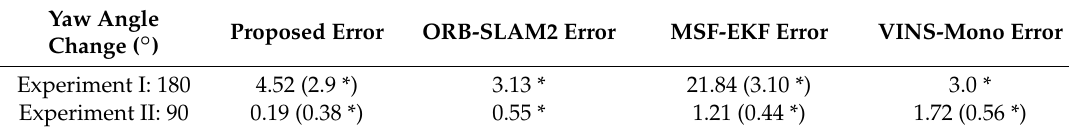
Table 2. RMSE ( ◦ ) of yaw angle estimation in different methods. (Value marked with an asterisk (*) was obtained before VO failure.)